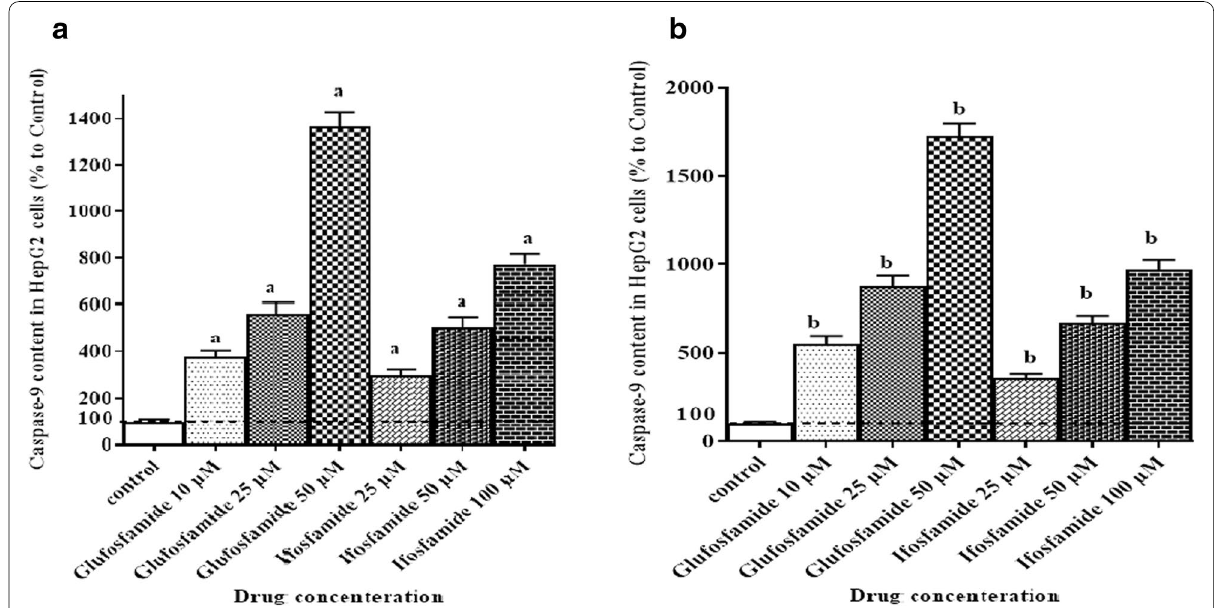
Fig. 3 Effects of glufosfamide or ifosfamide on caspase-9 content in HepG2 cells. a Effects of glufosfamide and ifosfamide on caspase-9 content in the cell lysate of HepG2 cells at 48 h post-incubation. b Effects of glufosfamide or ifosfamide on caspase-9 content in the cell lysate of HepG2